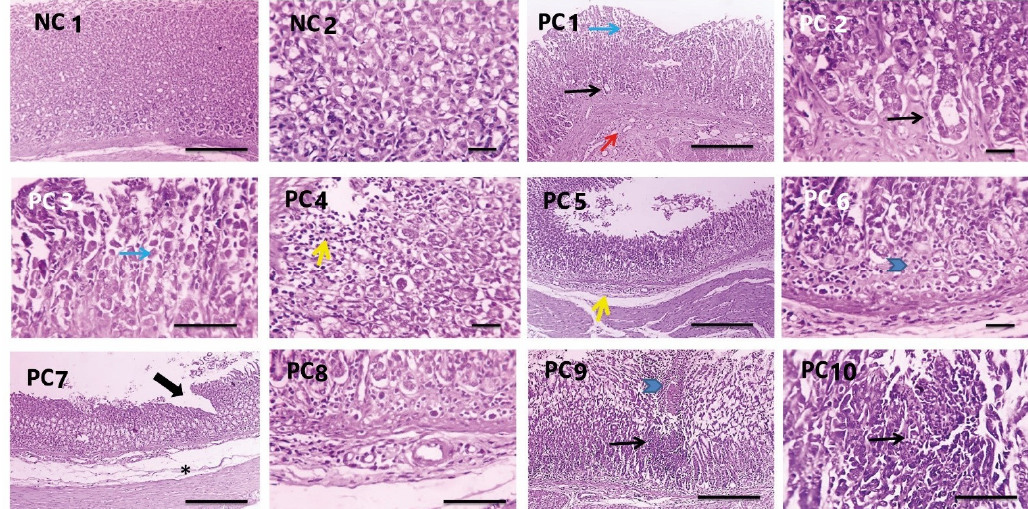
Figure 7. Microscopic pictures of H & E-stained glandular gastric mucosa showing normal gastric glands in the control normal group (NC1,2). Meanwhile, glandular gastric mucosa from the rats infected with H. pylori (PC1–10) showing metaplasia (black arrows) apoptosis (blue arrows), necrosis (blue arrowheads), focal ulceration (thick arrow) with submucosal congestion (red arrows), edema (*), and mononuclear cells infiltration (yellow arrows). Low magnification X: 100 bar 100 and high magnification X: 400 bar 50.